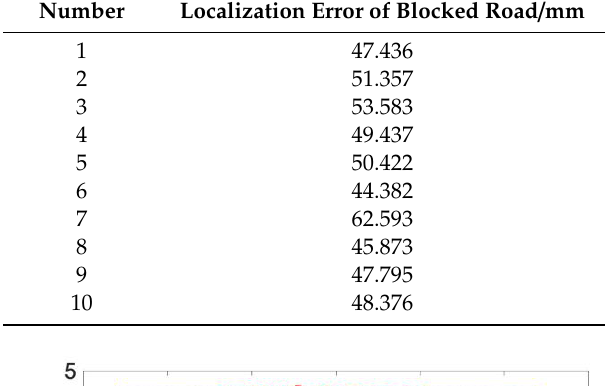
Table 4. The average errors of 10 fusion localization results on the blocked road.